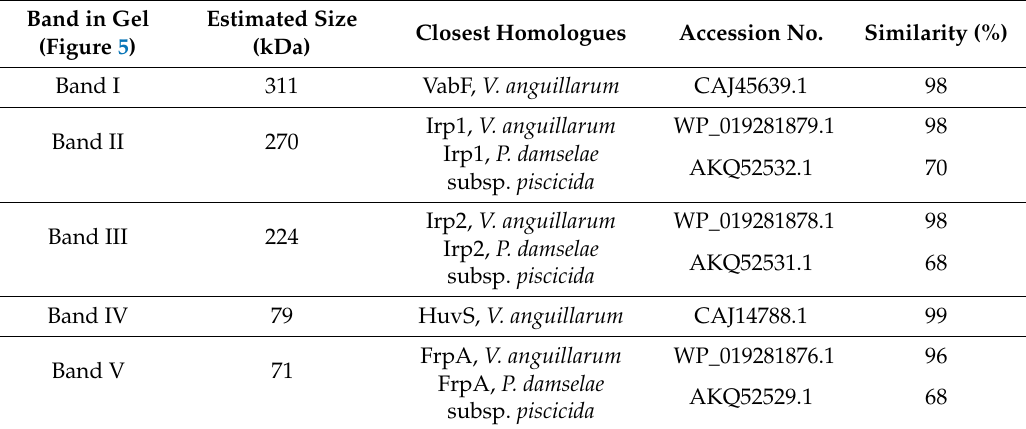
Table 2. Identification by peptide mass fingerprinting (PMF) of five proteins di ff erentially expressed under iron limitation in SDS-PAGE gel showed in Figure